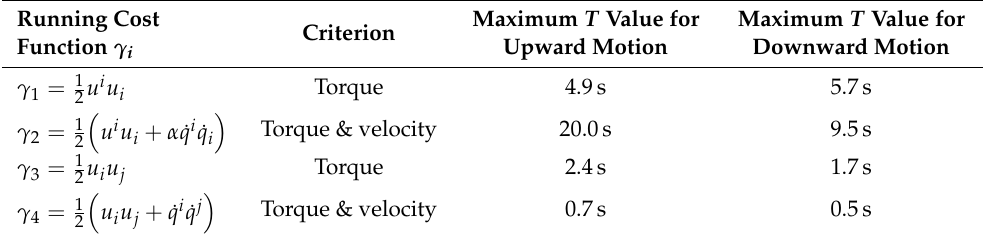
Table 1. Maximum prescribed times T for which NDSolve computes trajectories meeting conditions (53) and (54). The use of γ 2 allows the solver to reach higher values of T as compared to the other running cost functions. Note that both γ 1 and γ 2 are invariant; γ 3 and γ 4 are